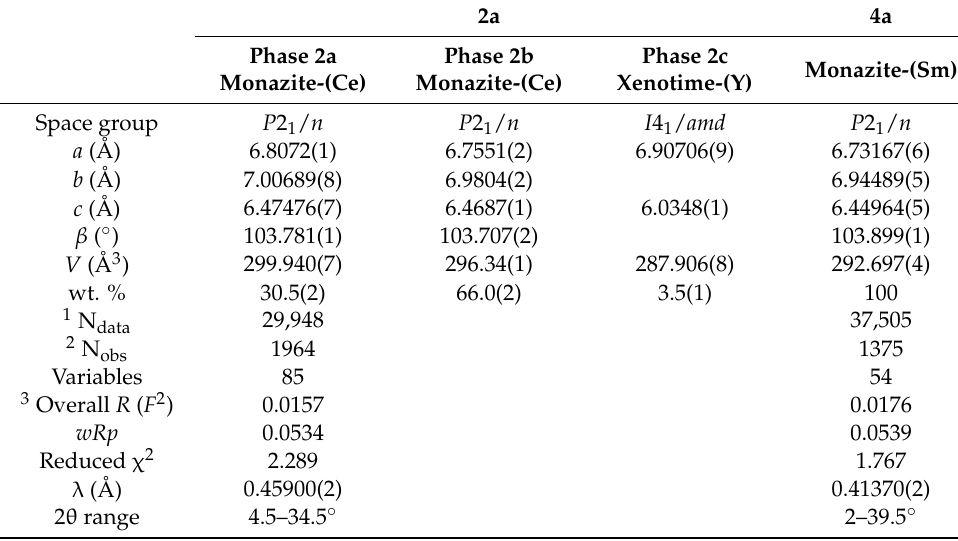
Table 6. HRPXRD data and Rietveld refinement statistical indicators for samples 2a and